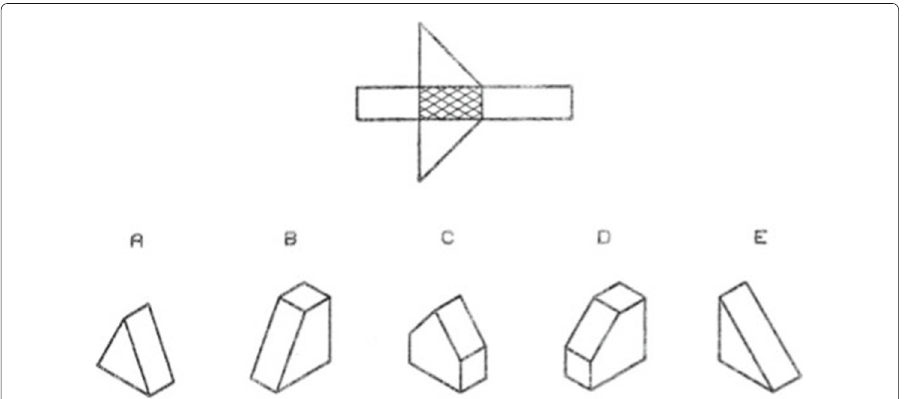
Fig. 1 Example problem in the Development section of